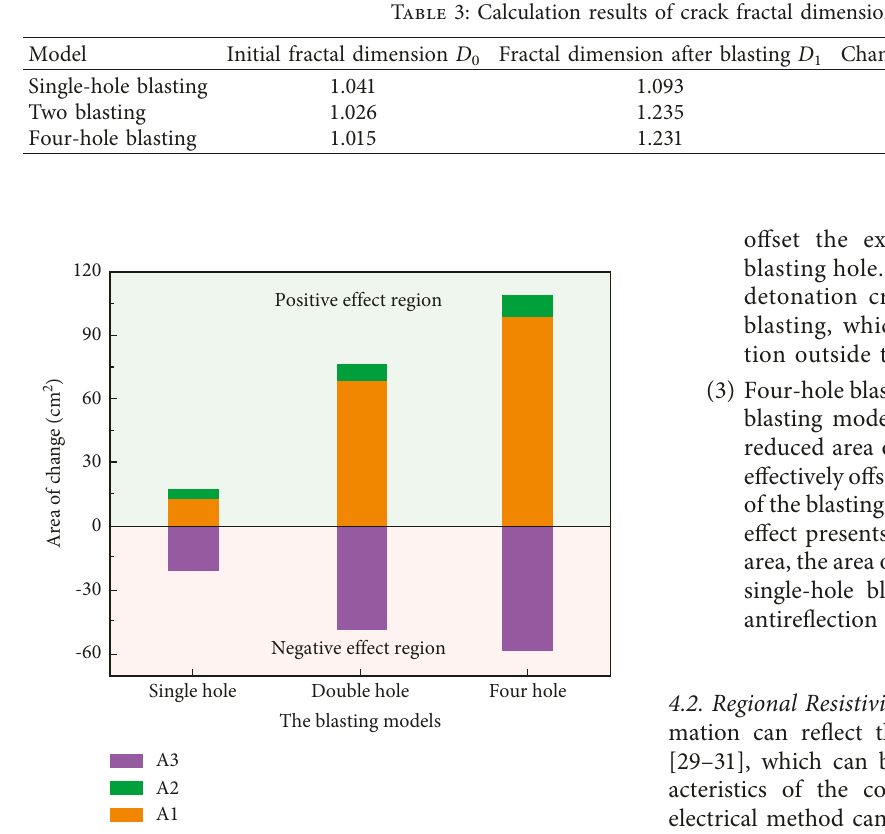
Figure 11: Analysis of permeability